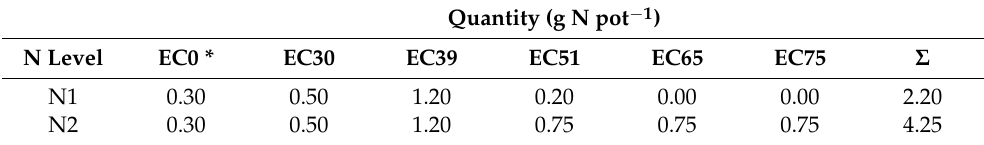
Table 1. Time course and quantities of N